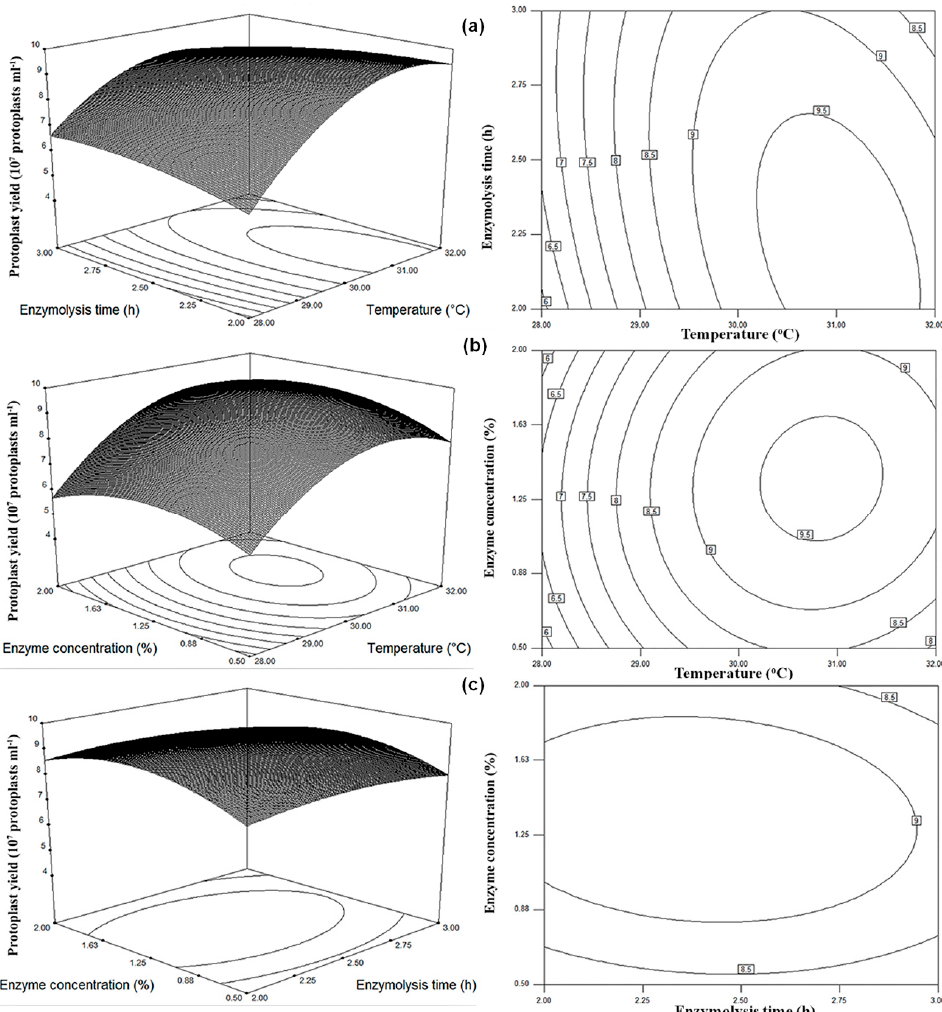
Figure 3. Response surfaces and contour plots showing: ( a ) the combined effect of temperature and enzyme lysis time on the protoplast yield; ( b ) the combined effect of temperature and lysing enzyme concentration on the protoplast yield; and ( c ) the combined effect of enzyme lysis time and lysing enzyme concentration on the protoplast yield.